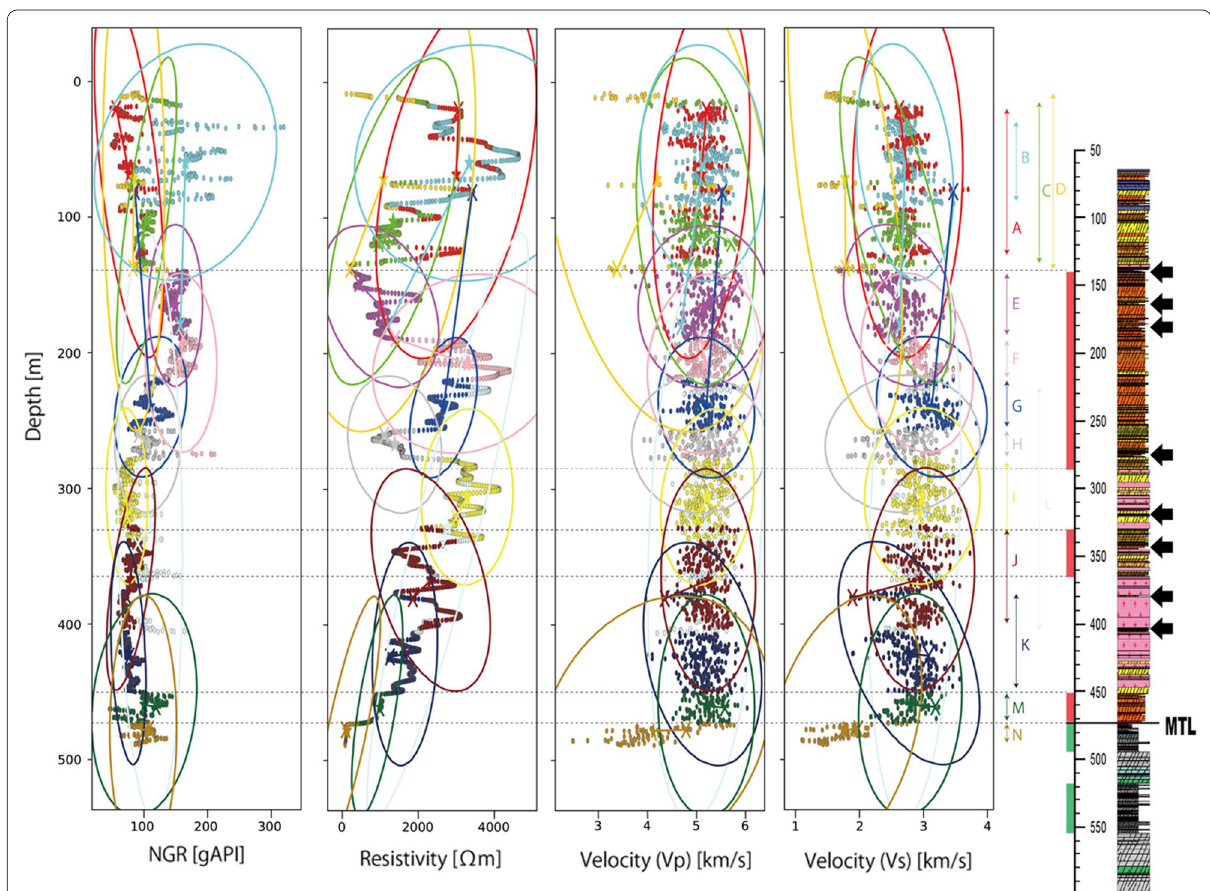
Fig. 7 Clustering results at ITA and core descriptions (Shigematsu et al. 2012). Ellipses represent covariance of each